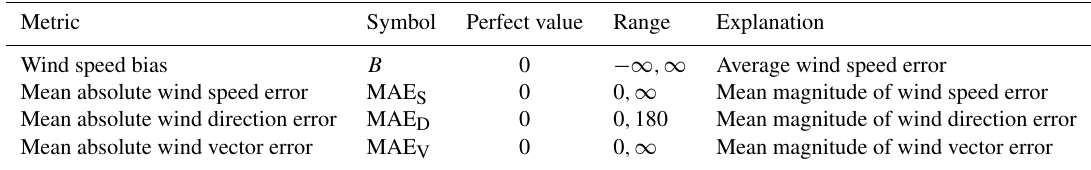
Table 3. Evaluation metric definition.